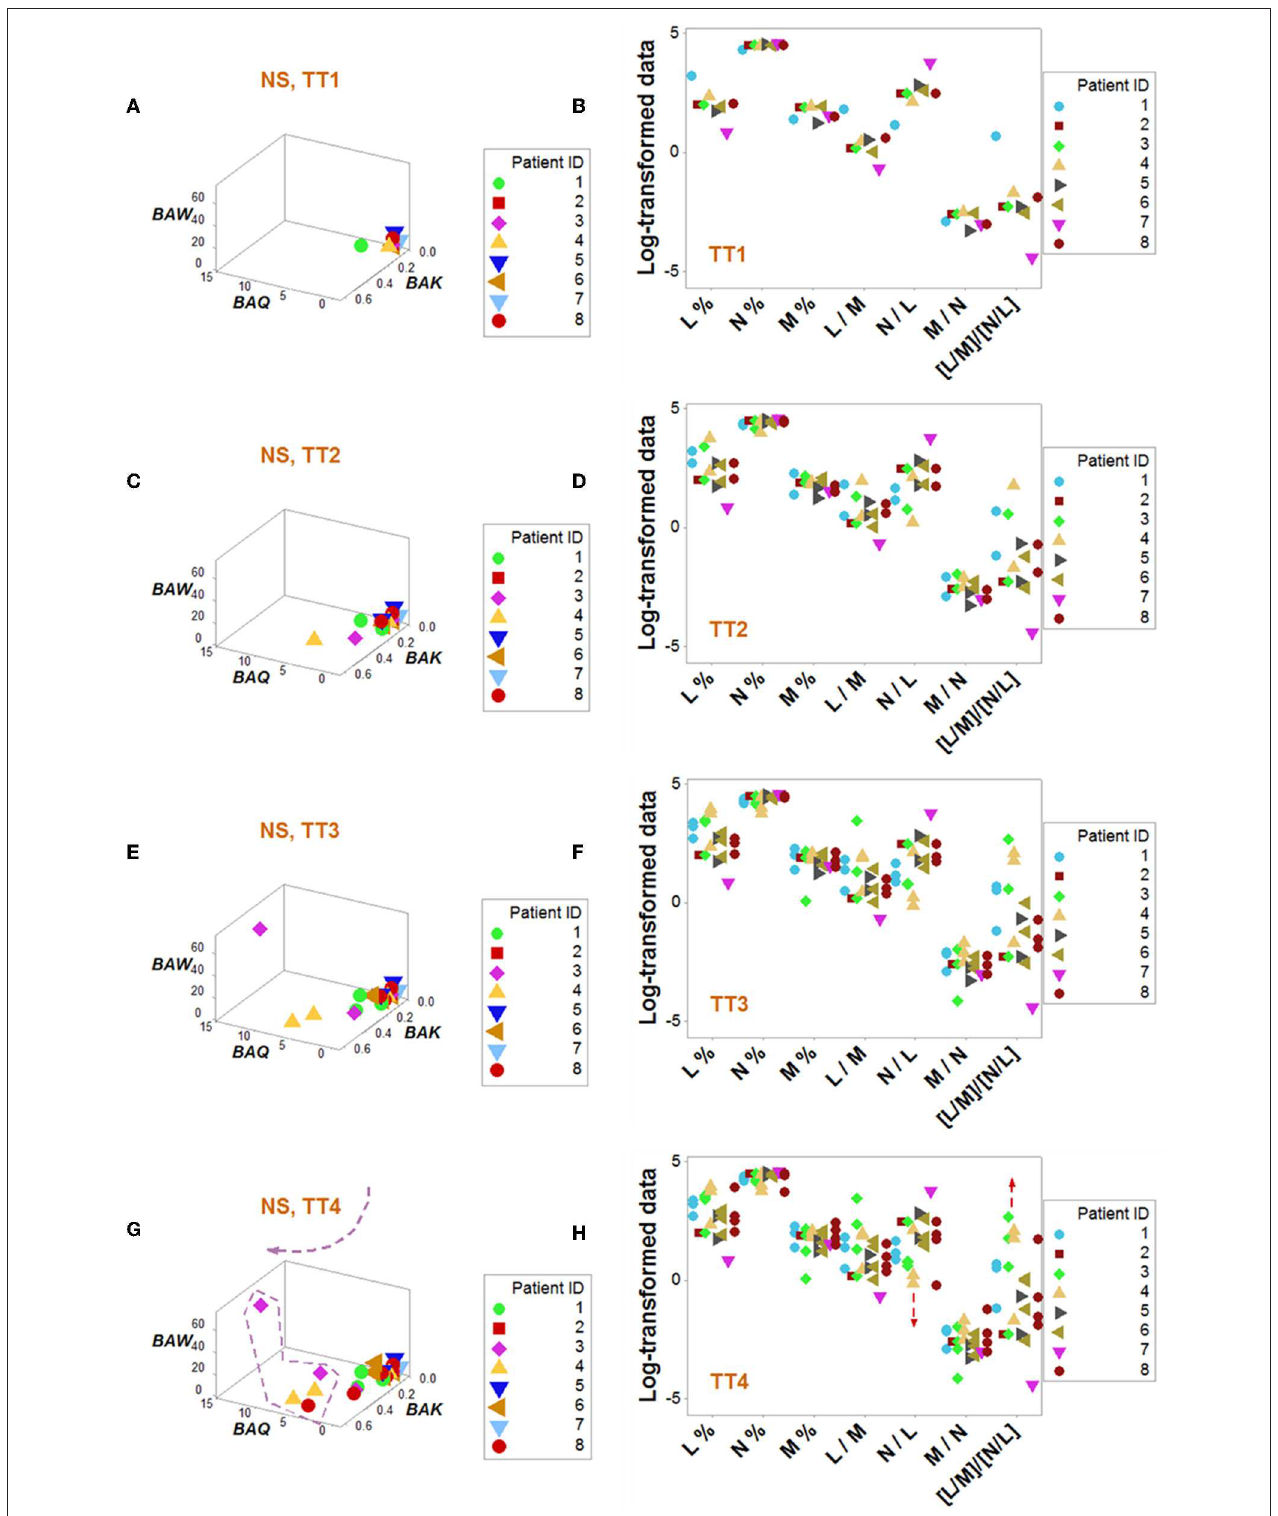
FIGURE 6 | Dynamic pattern-related prognostics (II): non-survivors. Spatial-temporal patterns of non-survivors revealed two subsets (A–H) : a subset detected at later times showed lower N/L and higher [L/M]/[N/L] values, i.e., a chronic inflammation (G,H) .